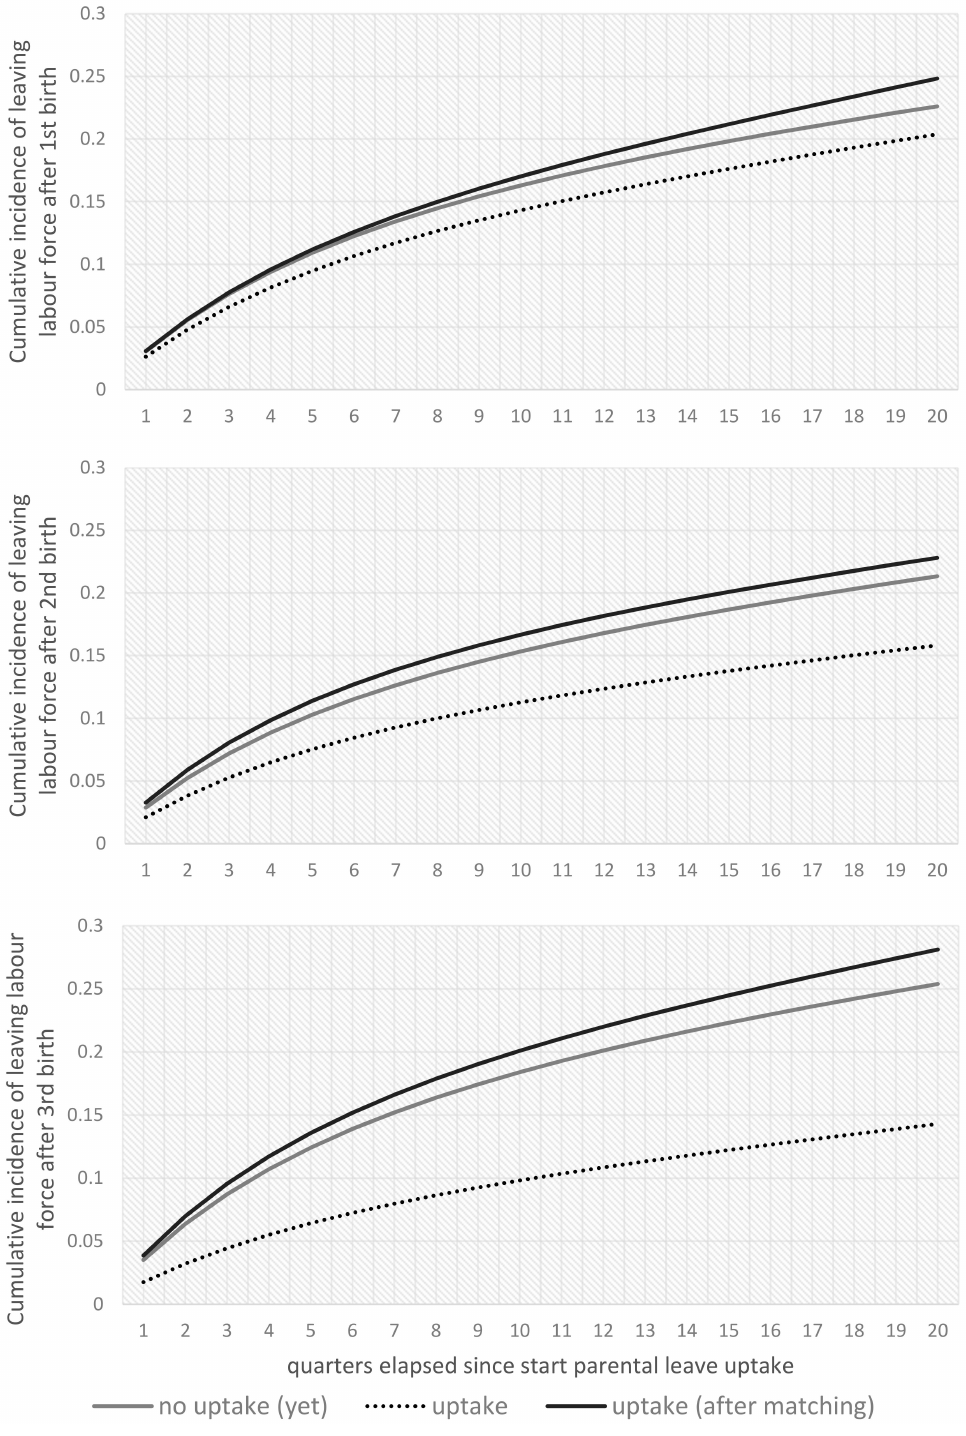
Figure 4. Leave uptake during the first year after childbirth and subsequent labour force exits. Source data: Belgian Administrative Socio-Demographic panel (ASD